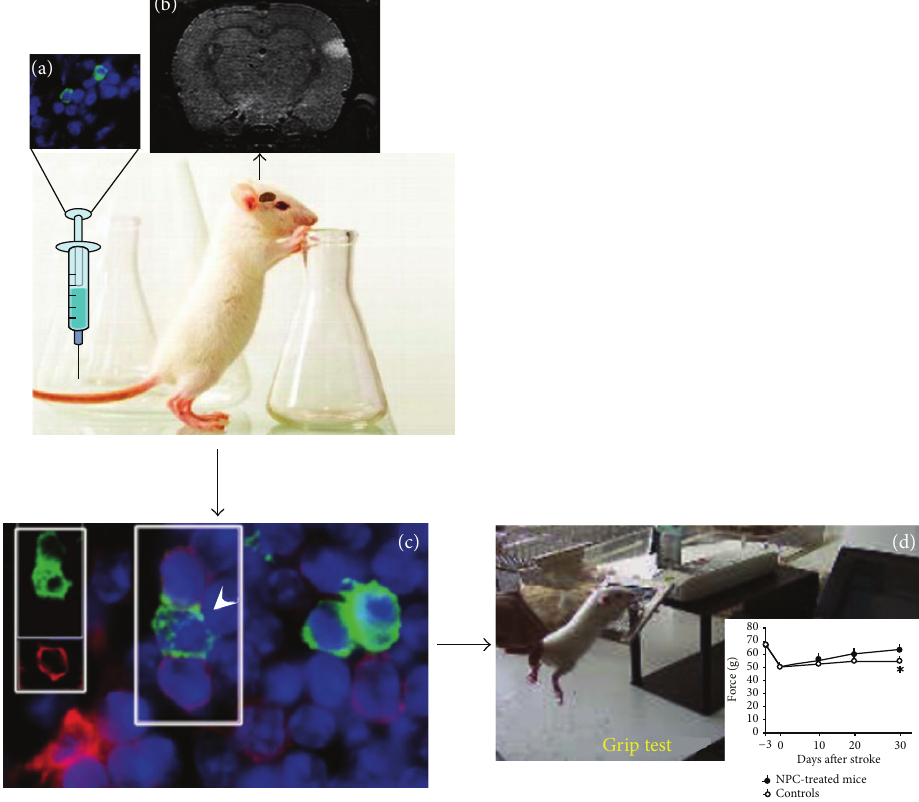
Figure 2: Neural stem therapy of cortical infarcts. (a) Administration of NPCs isolated from the SVZ is delivered at 72 h after reperfusion via the tail vein. (b) Documentation of the cortical infarct by MRI. (c) Visualization of transplanted cells in the peri-infarct. NPCs (arrowheads) at the ischaemic boundary zone were often detected in close proximity to phagocytes (red). Nuclei are labelled with DAPI (blue) (modified after [36]). (d) Behavioural assessment of cell treatment by the grip